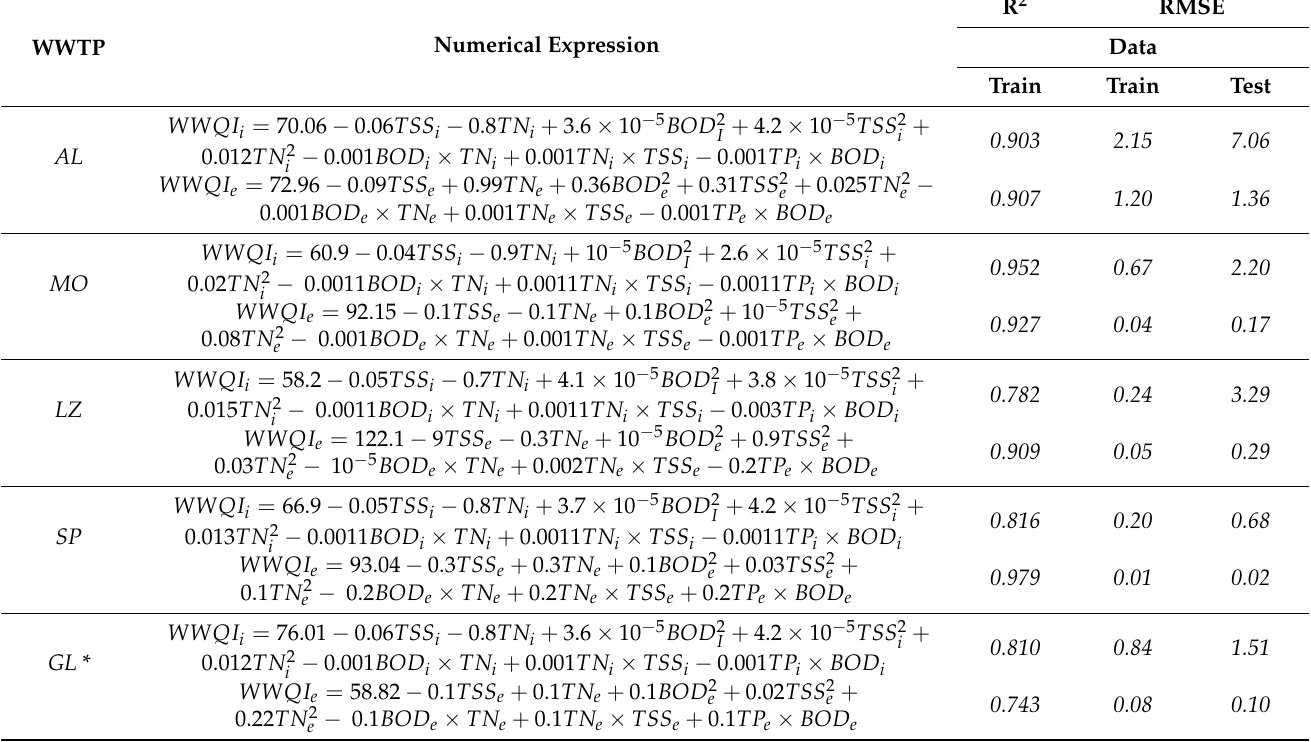
Table 4. Predictive statistical models of the raw and treated wastewater quality index. WWTP Numerical Expression